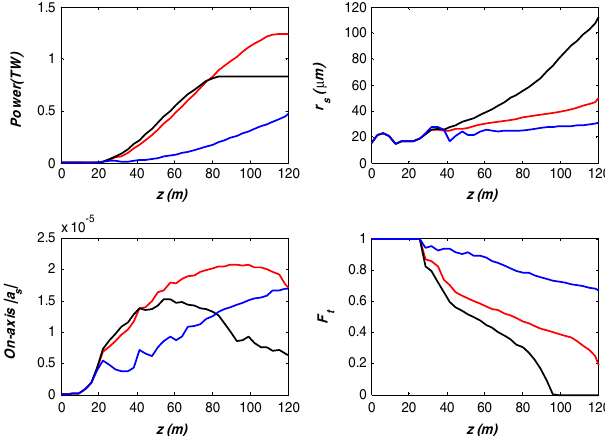
j ), on-axis j a b s ¼ b